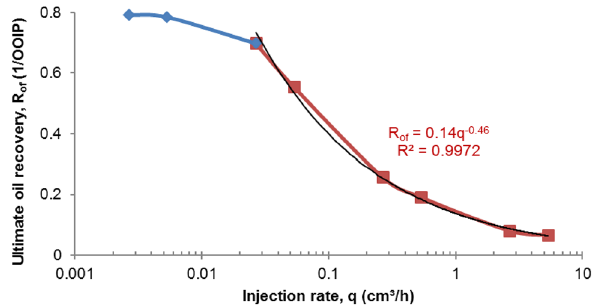
Table 7 Injection rate of surfactant solution and the steady pressure drop between injector and producer